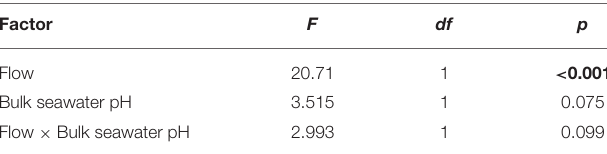
TABLE 2 | ANOVA summary for effects of flow and bulk seawater pH on photosynthesis of Favites .